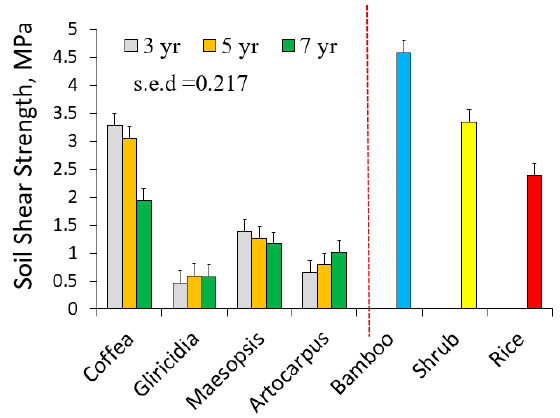
Figure 6. Soil shear strength (SS) at 5 cm depth for samples taken close to four species of trees and three types of non-trees.